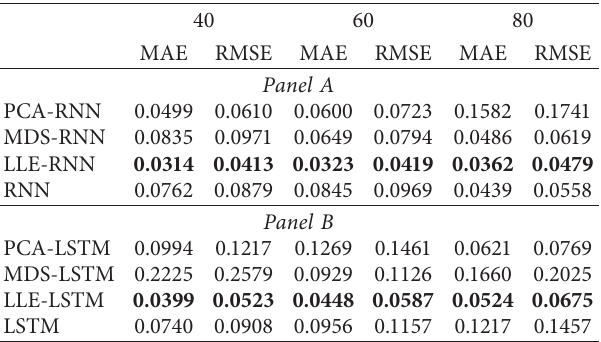
Table 10: Error with different window sizes (spot